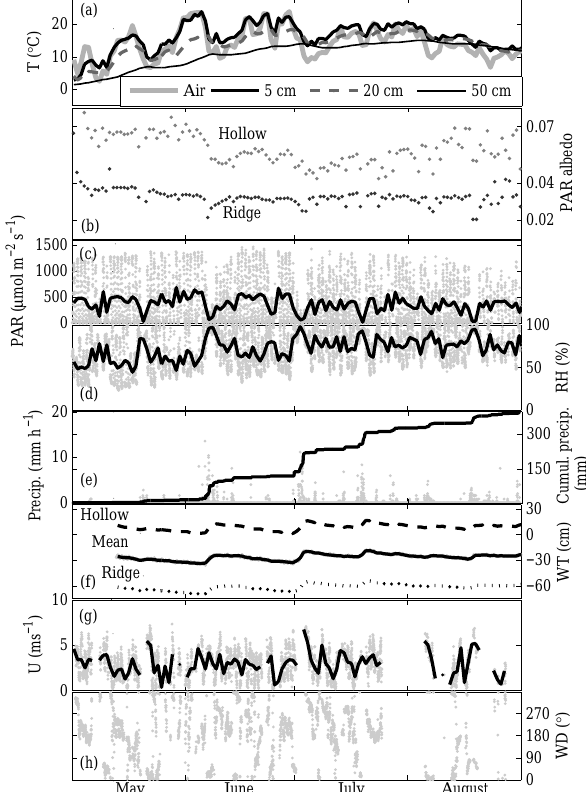
Figure 3. Time series of the environmental variables: (a) air and peat temperatures, (b) PAR albedo, (c) PAR, (d) relative hu- midity, (e) precipitation, (f) water table depth, (g) wind speed, and (h) wind direction. The grey dots are 30min measurements, while the lines represent daily averages, except in (b) in which the dots are midday (10:00–16:00UTC + 5) medians of PAR albedo and in (e) in which a bold line shows the cumulative precipitation. In (a) , the presented peat temperatures are area-weighted averages of two hollow and two ridge measurement